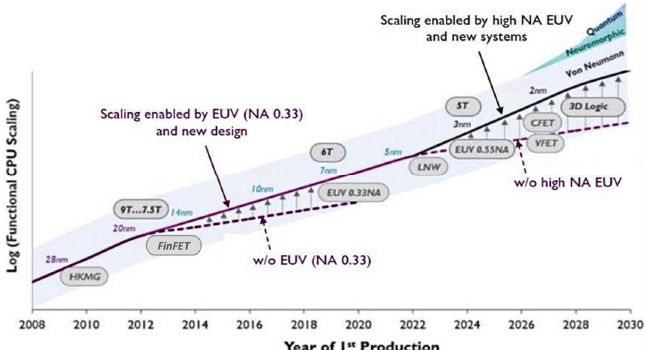
Figure 1. Technology node scaling is driven by the development of lithography. EUV will lead the industry in the next decade. Reprinted from [7], courtesy of IMEC.